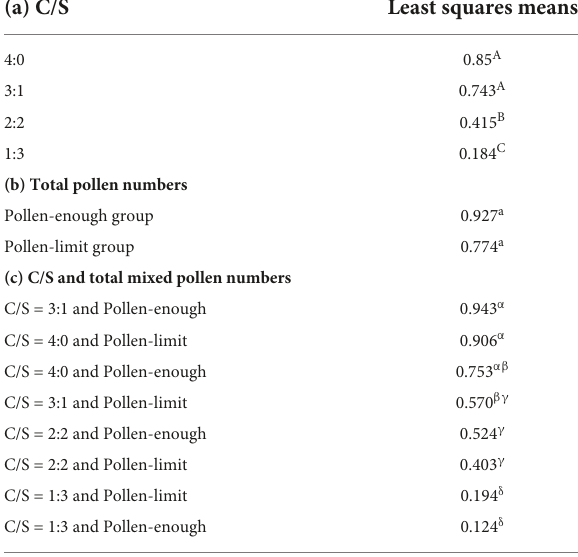
TABLE 3 Multiple comparisons on young fruit set of the least squares means between different ratios of cross- and self-pollen and total pollen numbers.